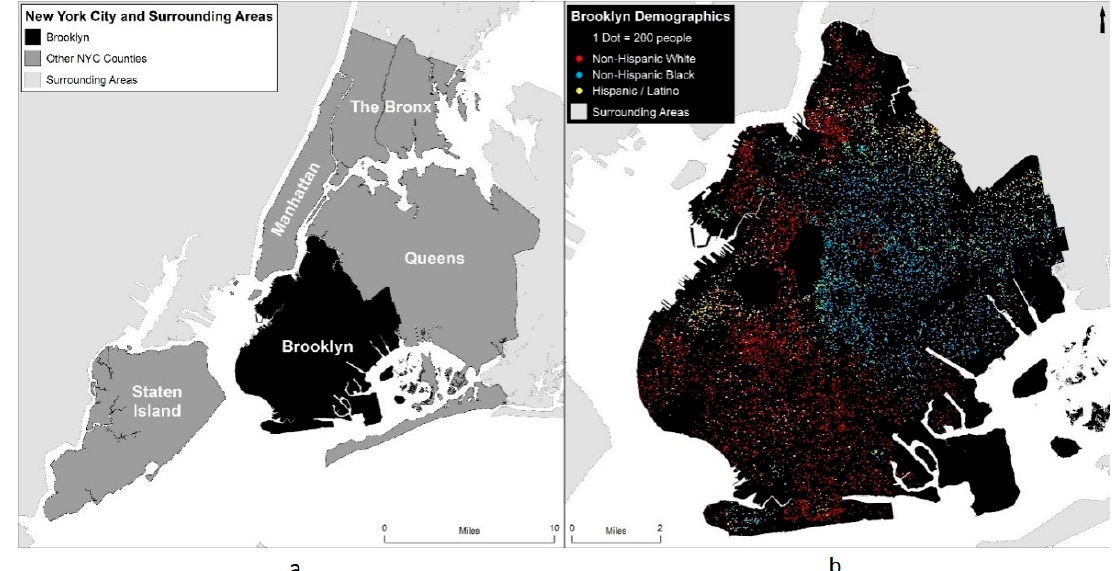
Figure 1. ( a ) Location of Brooklyn, NY within New York City; and( b ) race and ethnicity distribution in Brooklyn (2010).